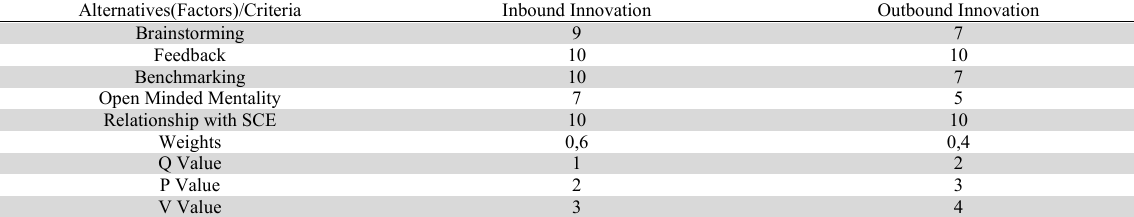
Raw scores of each alternative for each criterion Alternatives(Factors)/Criteria Inbound Innovation Outbound Innovation Brainstorming